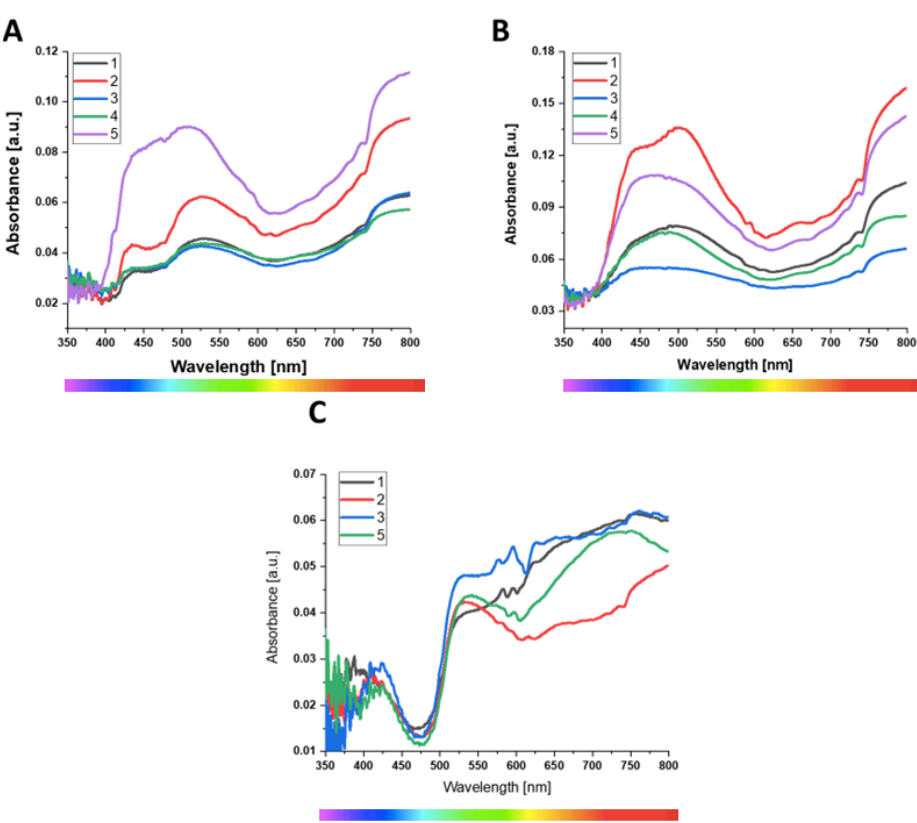
Figure 5. Visible absorption spectra after final treatments of the fancy diamonds: green ( A ), blue ( B ), and yellow ( C ). Green and blue display intense absorption bands between 400 and ~600 nm (H3) and a second absorption band located at 741 and 744 nm (GR1). Yellow displays an increase in absorption intensity from ~400 nm to ~470 nm, with a small N3 line (~415 nm). Numbers 1–5 denote the numbers of the sample diamonds (for yellow diamonds, sample 4 was omitted). Blue and green diamonds display visible spectra with a large band between 400 and ~600 nm, which may be associated with the H3 defect (N-V-N defect) [2]. The GR1 center is attributed to the neutral isolated vacancy (V°) located at 741 and 744 nm, which is seen in both green and blue diamonds [34].